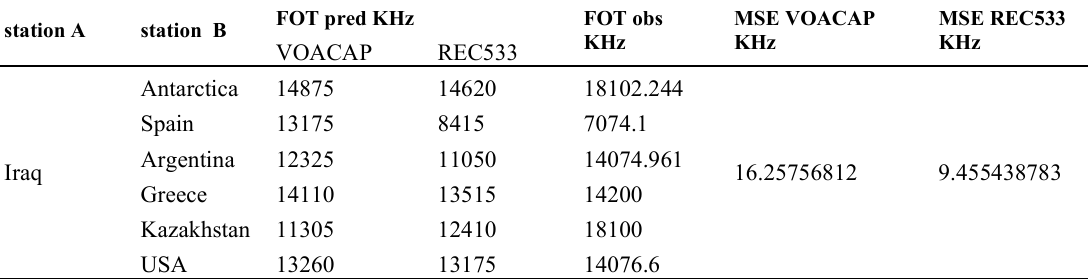
Shows the MSE between real contact data and predicted data station A station